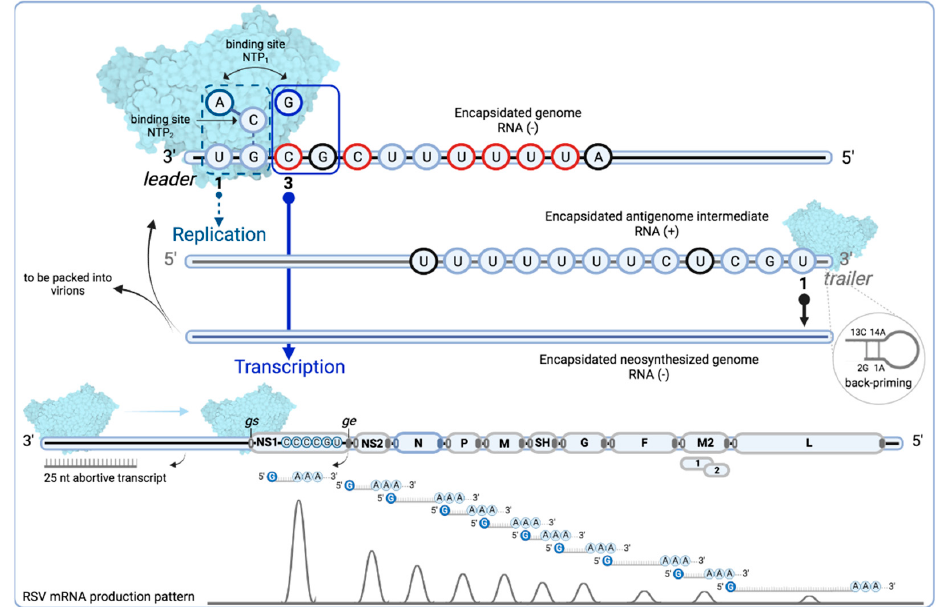
Figure 4. Schematic diagram of the proposed mechanisms for replication and transcription initiation for the respiratory Syncytial virus L protein. Overview of the de novo initiation at two sites in the RSV leader ( le ) promoter showing the two nucleotide binding sites, NTP 1 and NTP 2 , in the cat- alytic center of the RdRp. The RSV polymerase complex (PDB: 6PZK) is shown in molecular sur- face. The first 11 nucleotides of the le are shown to indicate that they are sufficient to signal initia- tion of RNA synthesis according to a minigenome assay, with nucleotides 3, 5, 8, 9, 10, and 11 in red required for both transcription and replication; nucleotides in black show differences with respect to the tr sequence. The dashed line box of NTP 1 (which has affinity for ATP or GTP) shows ATP bound to the RSV RdRp active site independently of the template sequence to prime initiation (replication in a nontemplate fashion). CTP bound to NTP 2 contacts the GTP of the le promoter and makes a hydrogen bond facilitating or enabling the polymerase to catalyze phosphodiester bond formation between the ATP and CTP residues. Alternatively, the CTP could first engage the RdRp active site, followed by recruitment of ATP. This leads to pairing the ATP in the position 1U of le and the start of replication. The polymerase moves forward along the le template, adding com- plementary bases from 5 ′ to 3 ′ direction to produce a positive sense antigenome intermediate RNA that is encapsidated (blue oval throughout the sequence line) as it is synthesized. For production of RSV genome to be packaged in the virions, or to be used as a template for new replica-